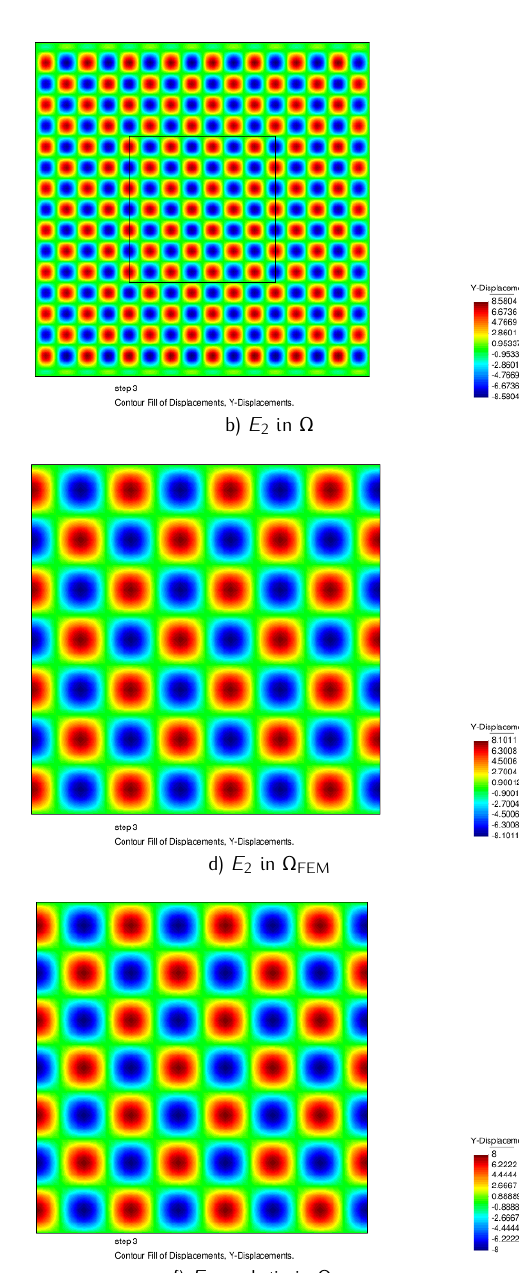
of the ,E 1 h 2 h )